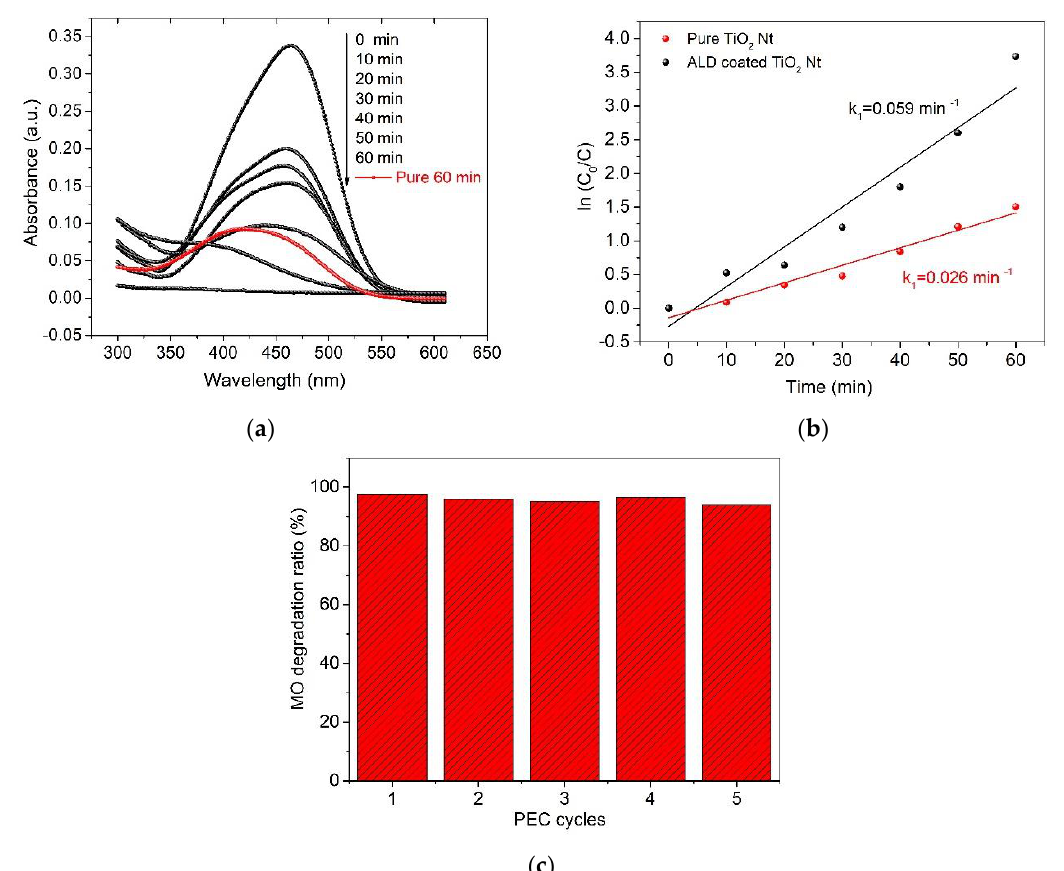
Figure 8. Temporal absorption spectral patterns of methyl orange (MO) during the photoelectrocatalytic process ( a ) using pure and ALD-coated TiO 2 Nt under UV-Vis light irradiation. ( b ) First-order reaction kinetics curves. ( c ) Photoelectrocatalysis cycles of MO degradation using ALD-coated TiO 2 Nt under UV-Vis light irradiation.